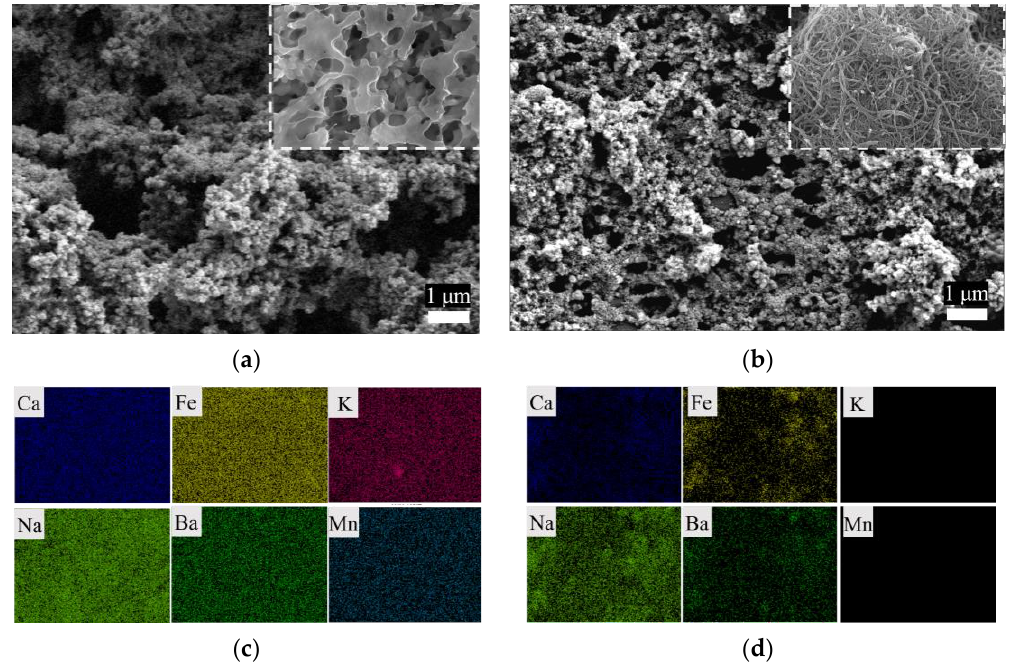
Figure 5. SEM-EDS images of the ( a , c ) PVDF and ( b , d ) PVDF-CNT-FAS membranes. The top-inserted image refers to the virgin membrane.